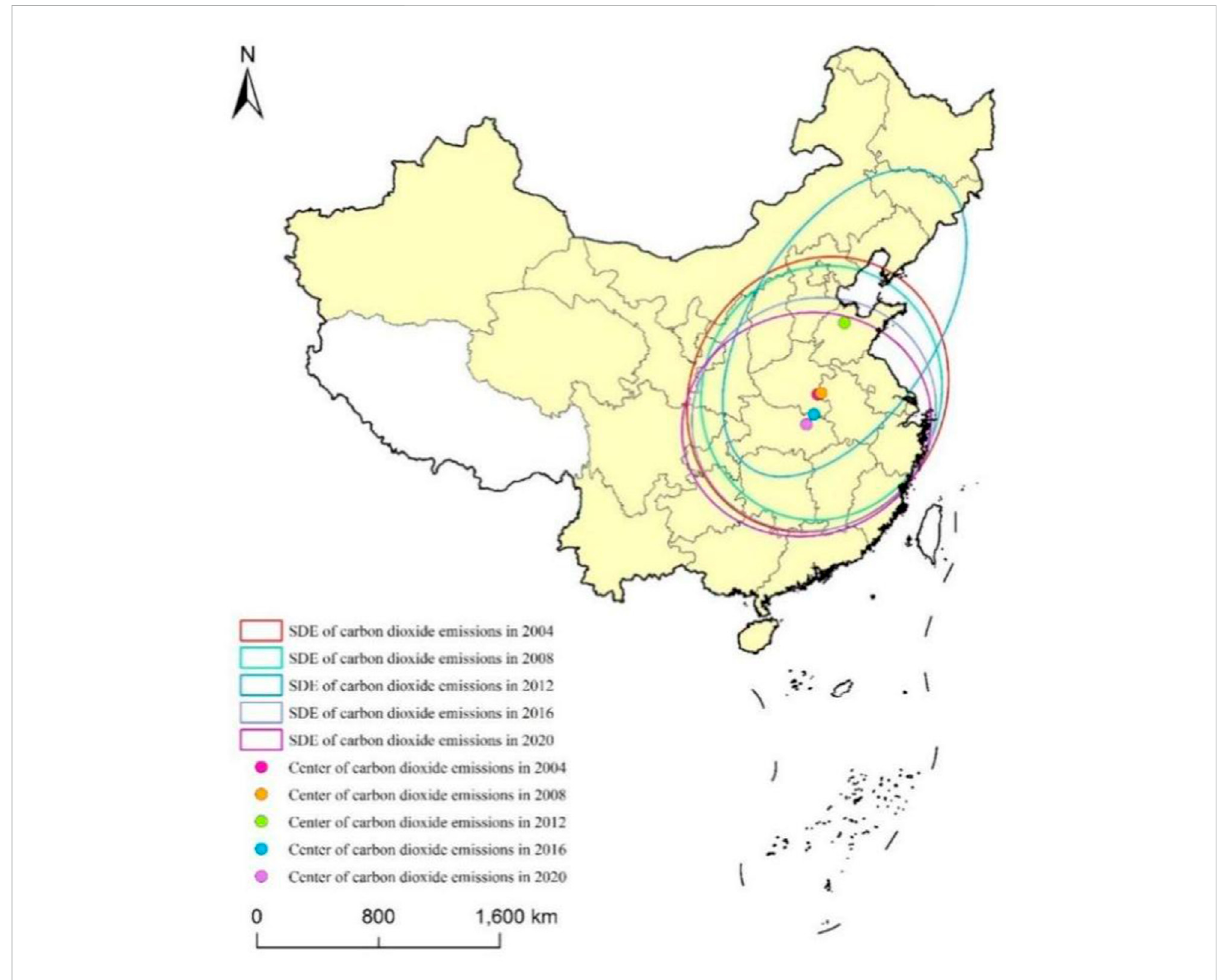
FIGURE 2 Elliptic evolution result of standard